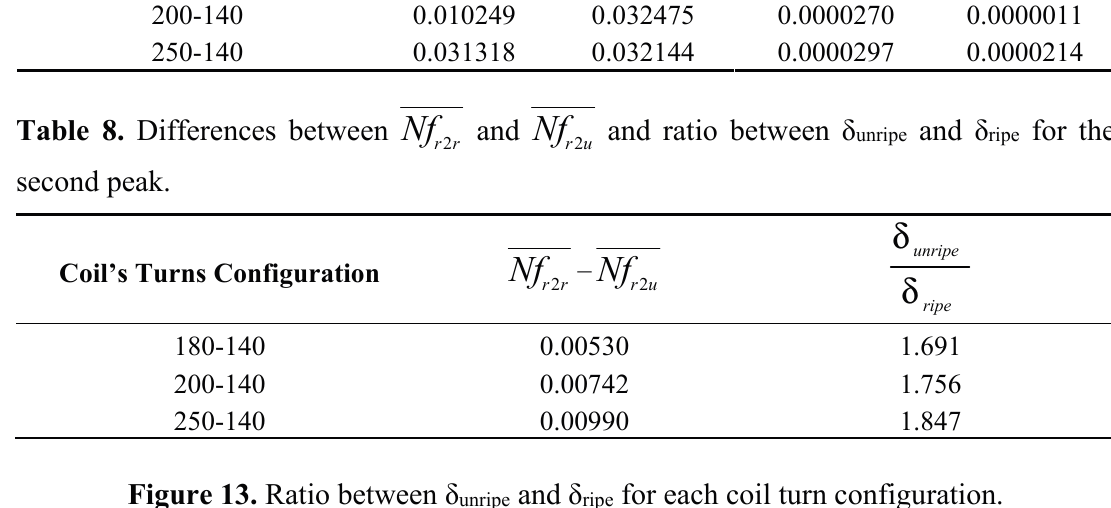
Figure 13. Ratio between δ unripe and δ ripe for each coil turn